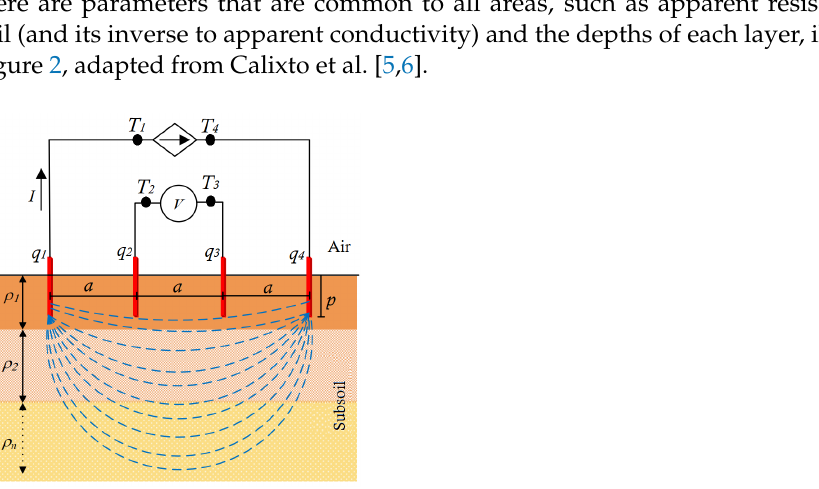
Figure 2. Wenner’s method used to collect the soil resistivity data in